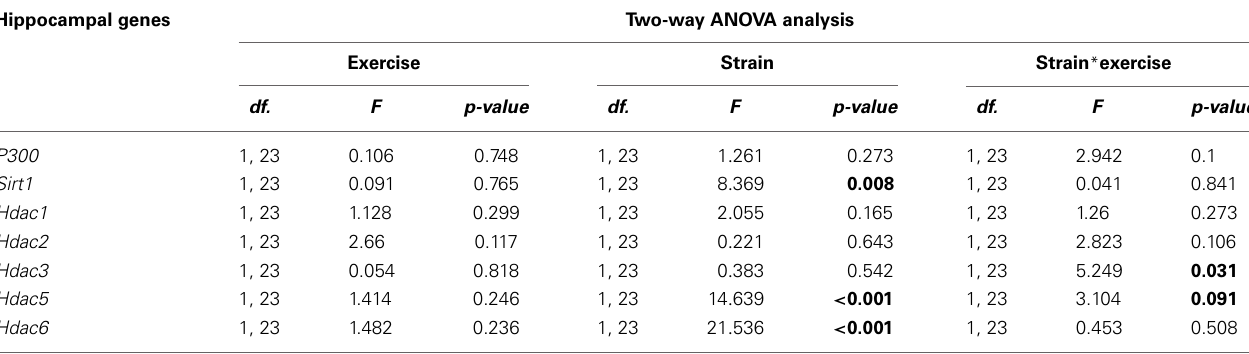
Table 3 | Two-Way ANOVA was used to compare the hippocampal expression of histone acetylation regulatory genes in sedentary and exercised 8-month-old SAMR1 and SAMP8